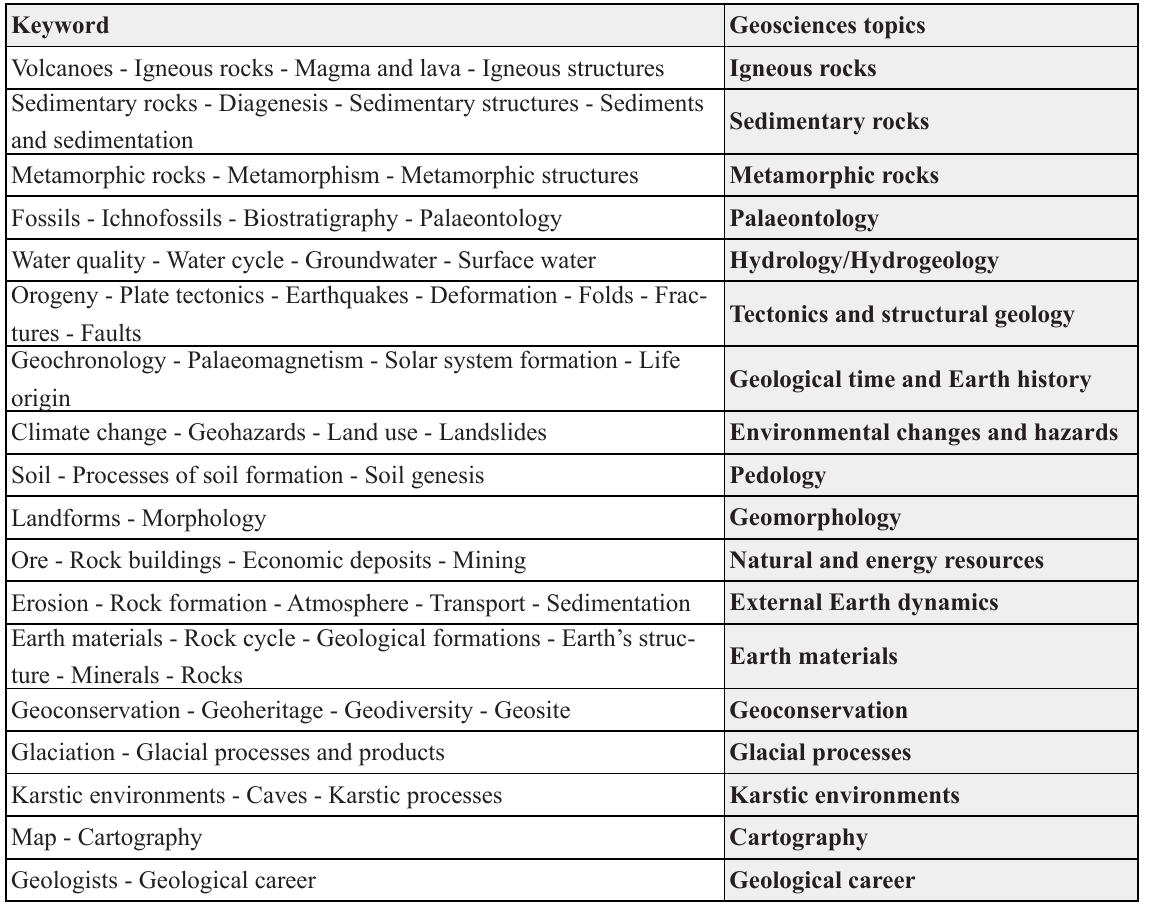
Table 1. Keywords and geoscientific topics associated with the main content of the educational materials. The left column includes some keywords that compose the geosciences topics in the right